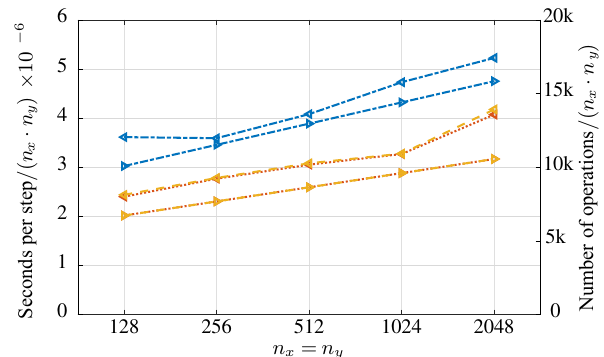
Figure 5. Computational cost of the convective module as a func- tion of the horizontal resolution. The timing of the module is pre- sented on the left vertical axis and represented by left-pointing arrows. The number of operations is shown on the right vertical axis and represented by right-pointing arrows. The three different dealiasing methods are plotted: the 3 / 2 rule as the blue dot–dashed line, the FT method as the orange dotted line, and the FS method as the yellow dashed line. The numerical resolutions are n x × n y × 128, run with 64 MPI processes and a domain decomposition of 8 × 8 el-